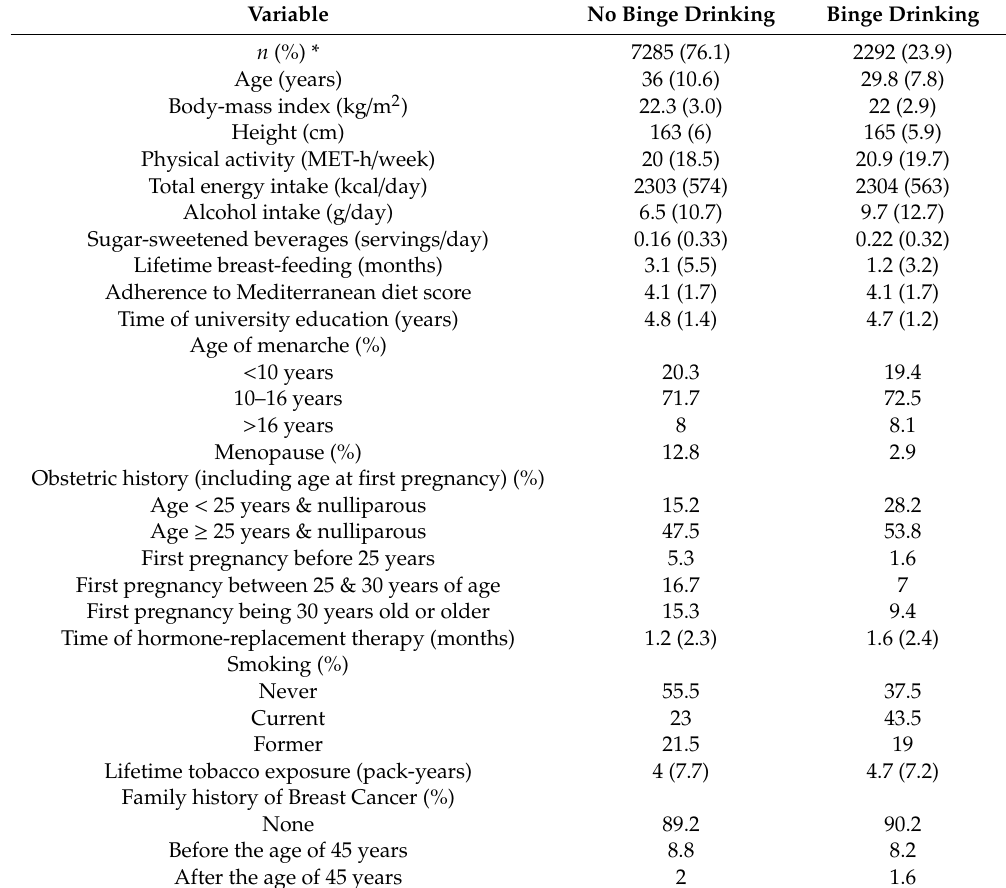
Table 1. Baseline characteristics of female participants in the SUN Project, according to binge drinking habit.